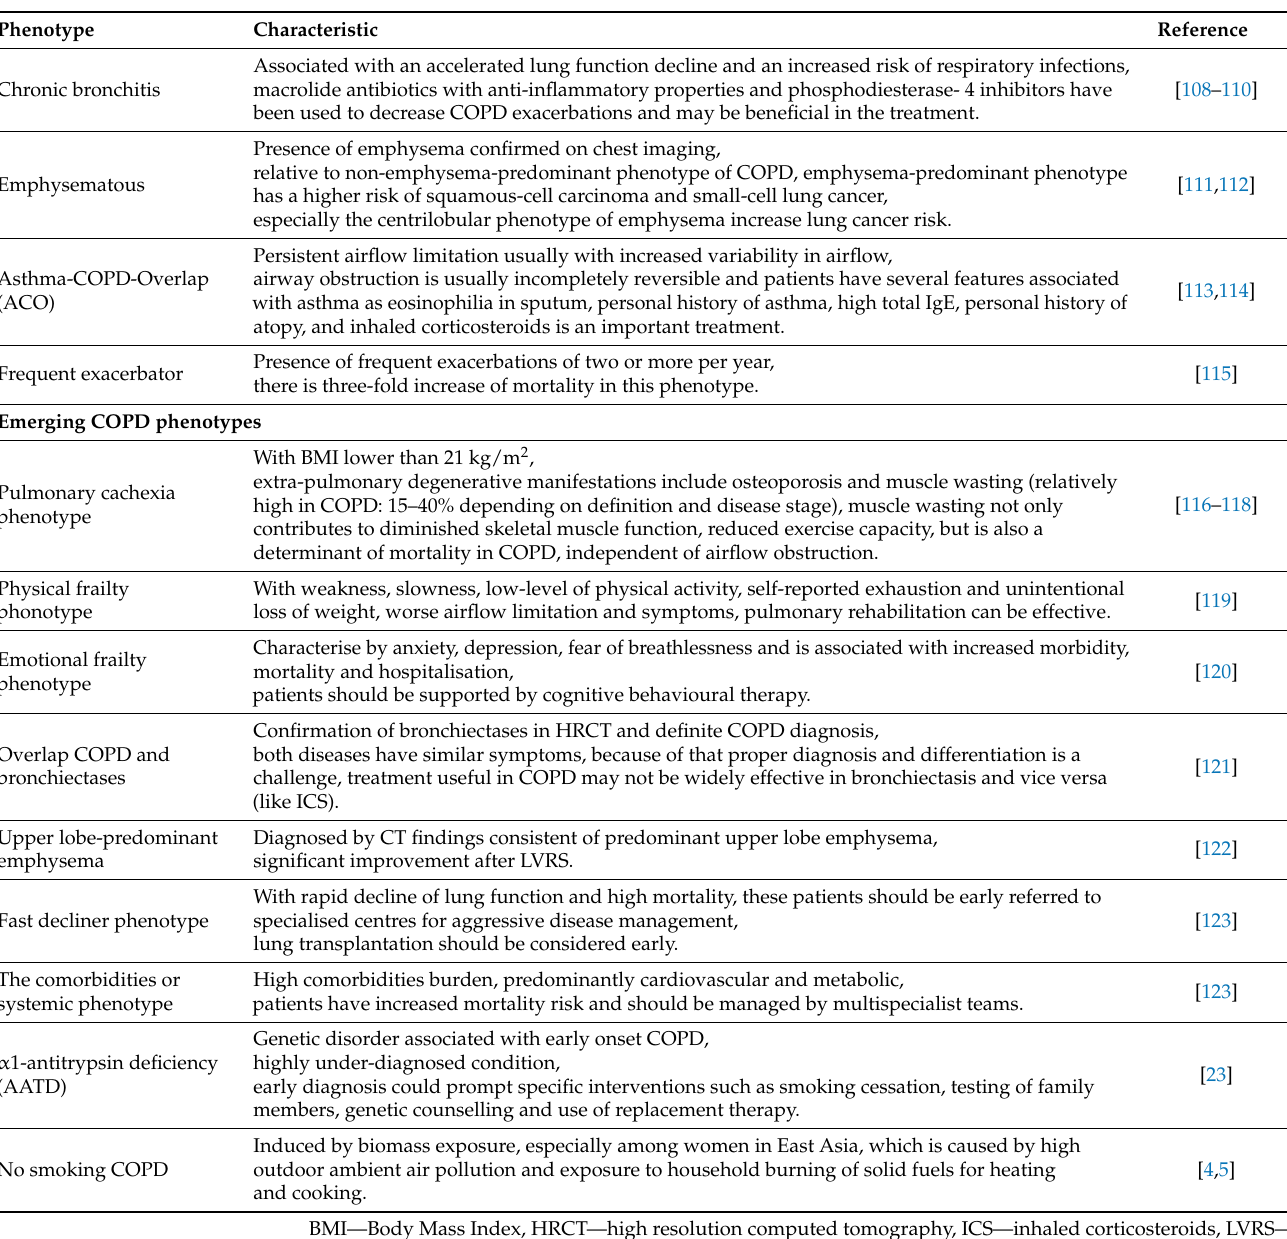
Table 1. Characteristic of phenotypes of chronic obstructive pulmonary disease (COPD) and relation with lung